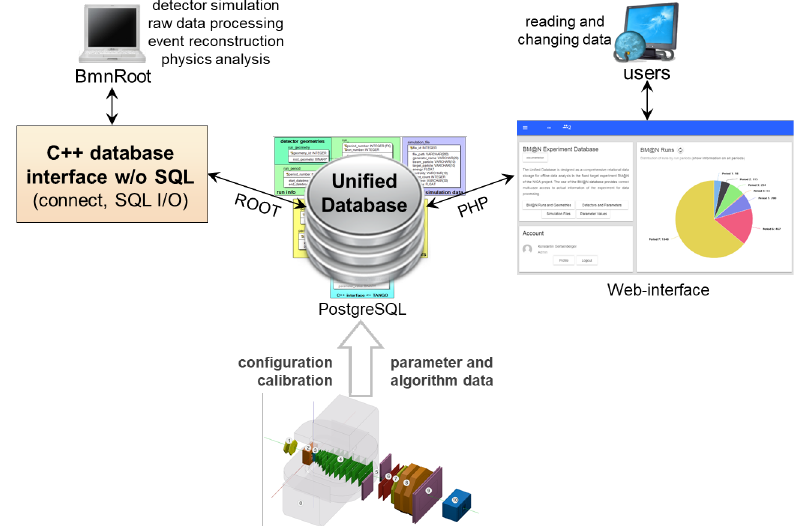
Fig. 5. General scheme of database relationships for the BM@N